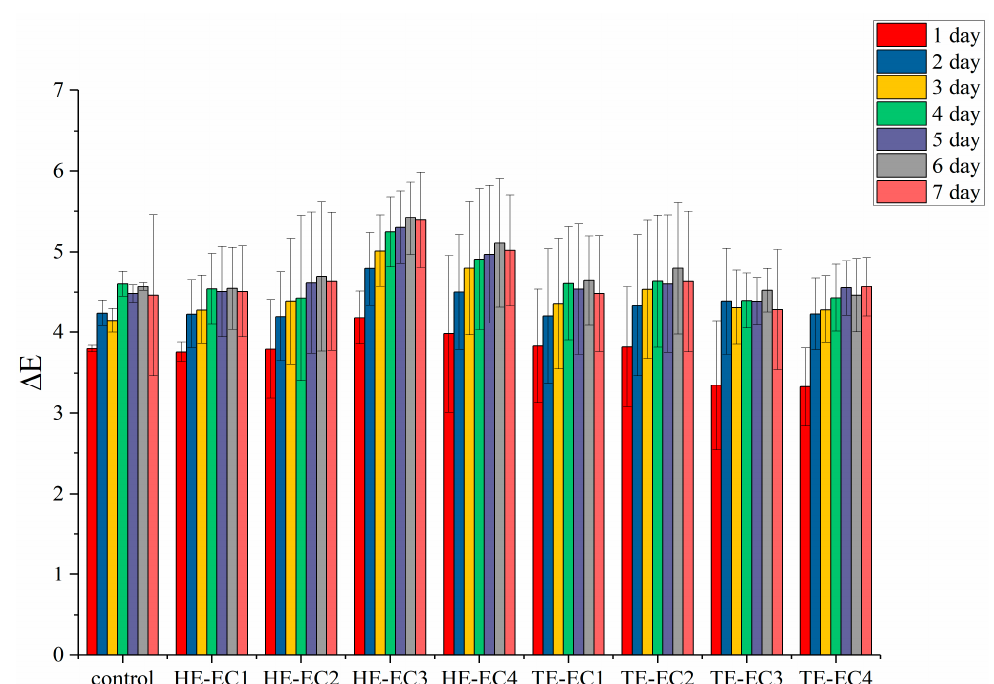
Figure 4. Color change ( ∆ E) mean values of experimental composite resins over one week. Vertical lines represent standard deviation.